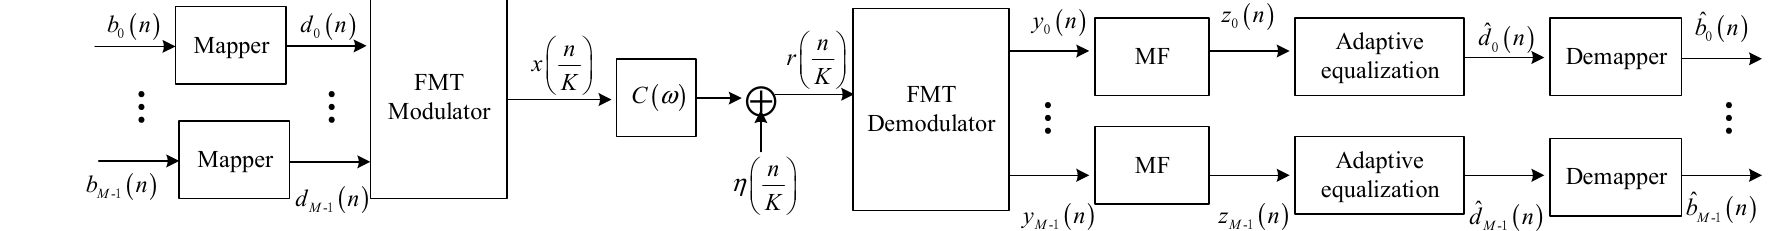
Figure 3. Block diagram for joint single-input–single-output (SISO) and adaptive equalization.